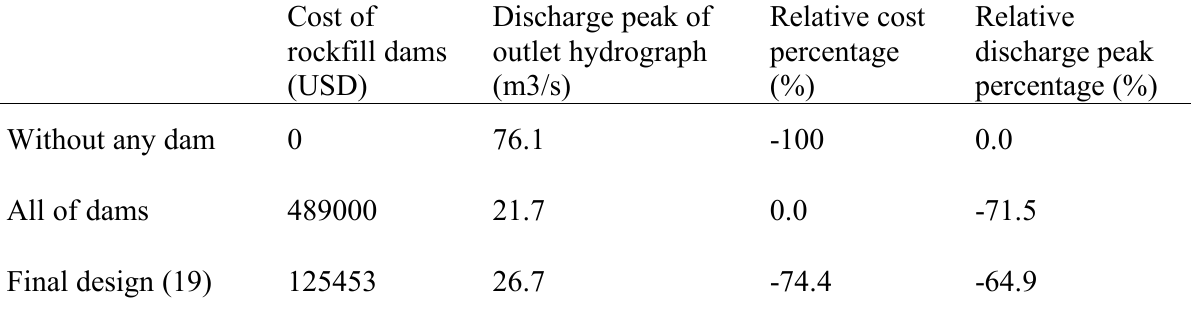
Table 4 . Comparison of the final flood control plan with two special